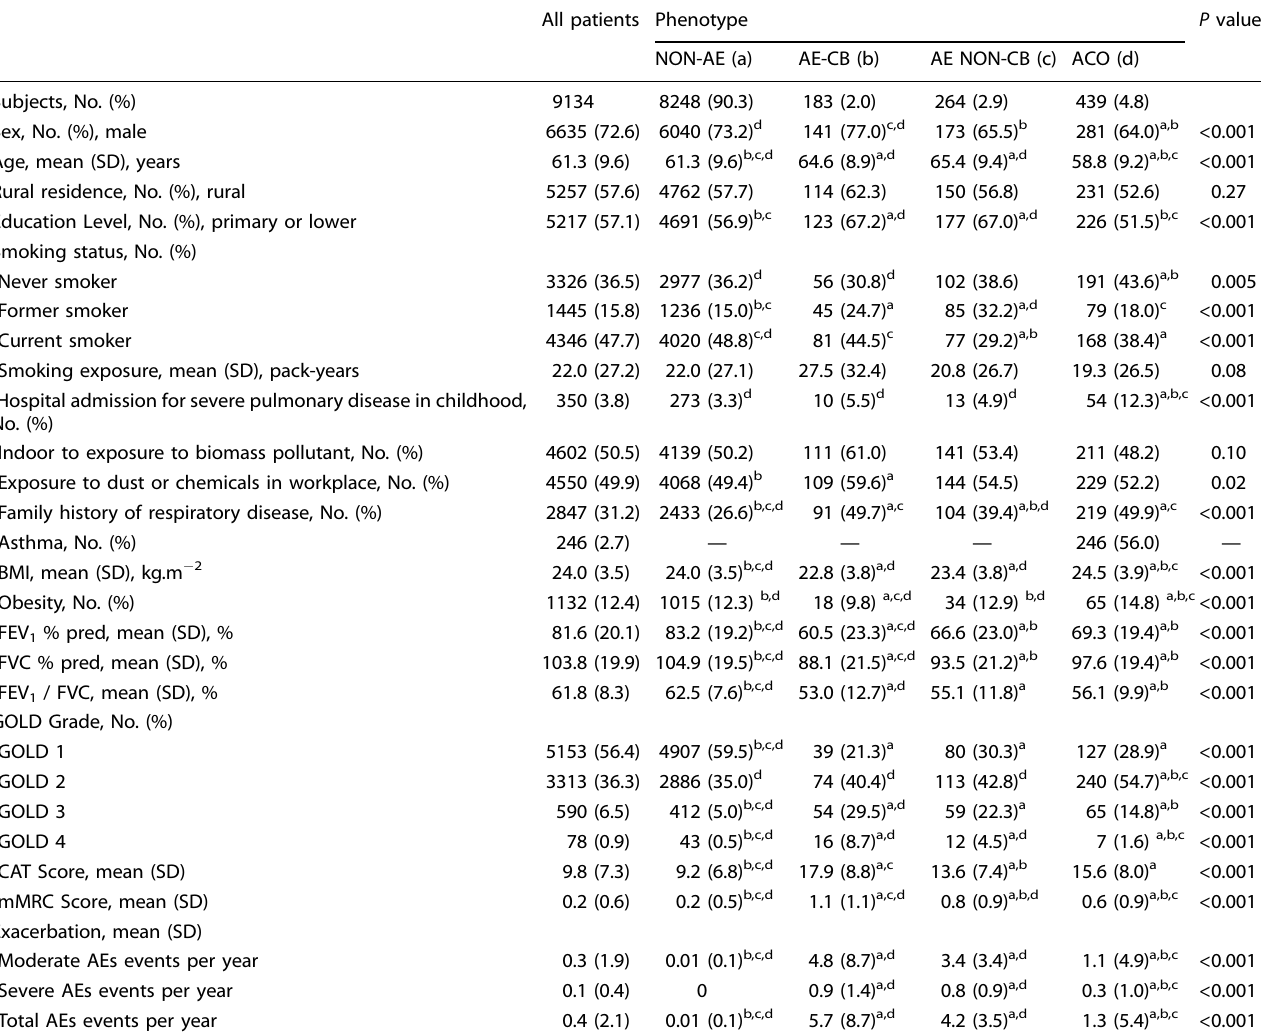
Table 1. Characteristics of patients with chronic obstructive pulmonary diseases according to